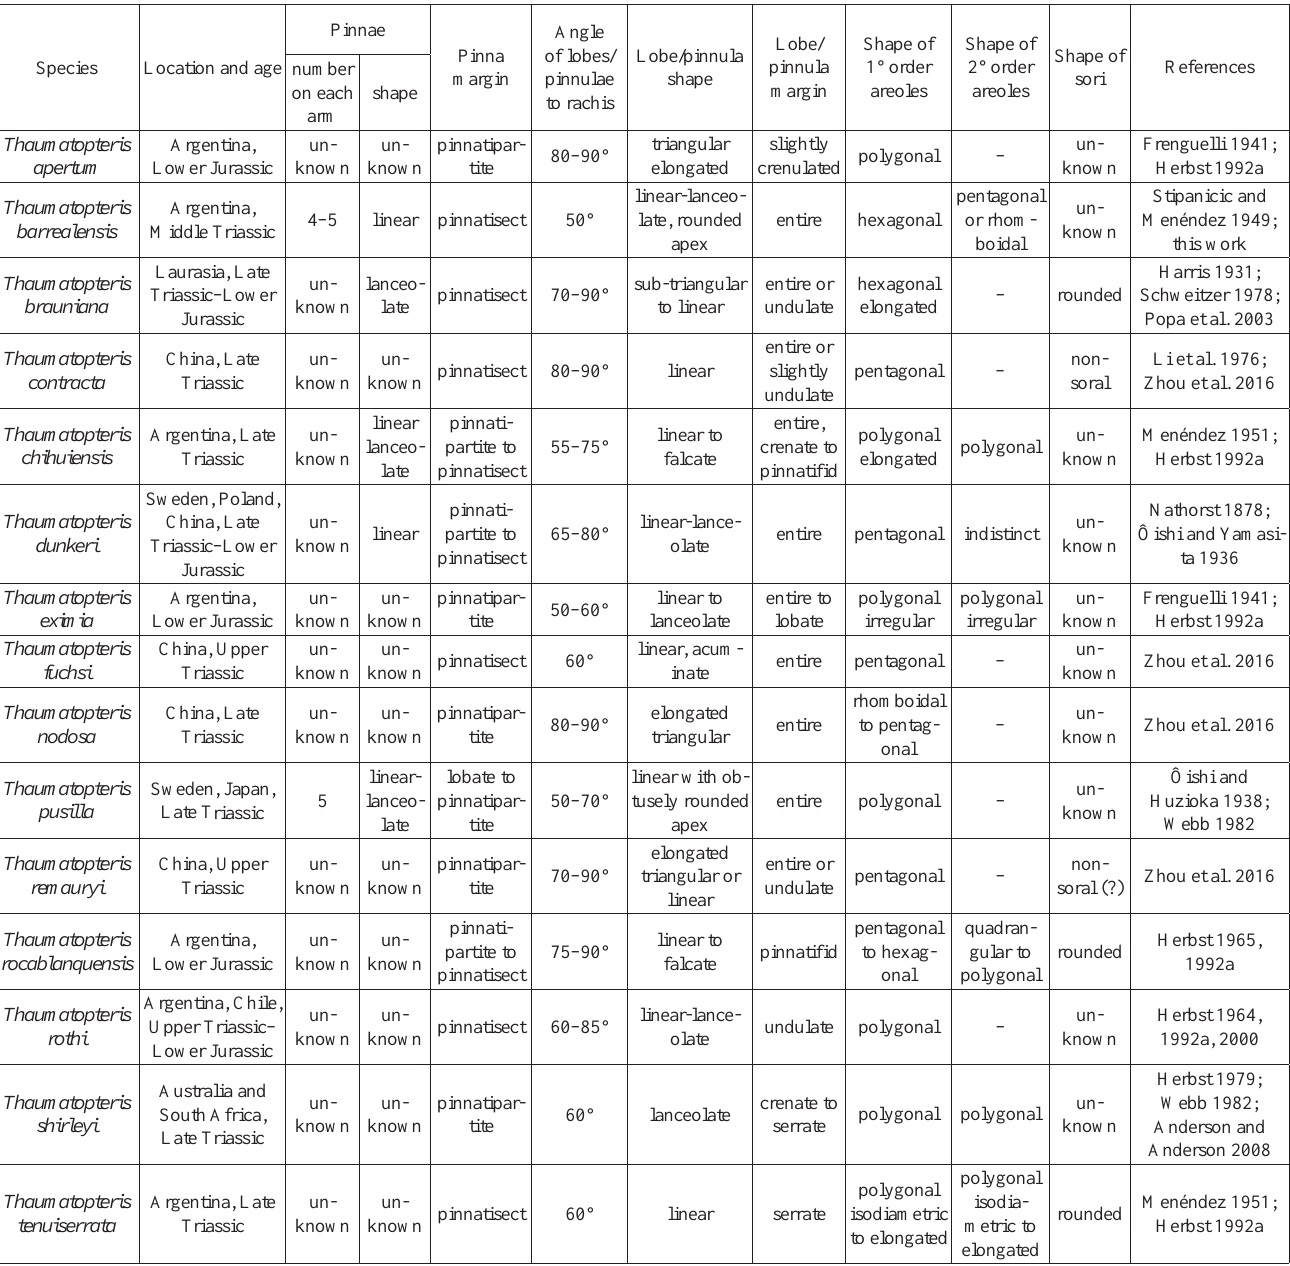
Table 3. Comparative table of the most representative species of the genus Thaumatopteris .